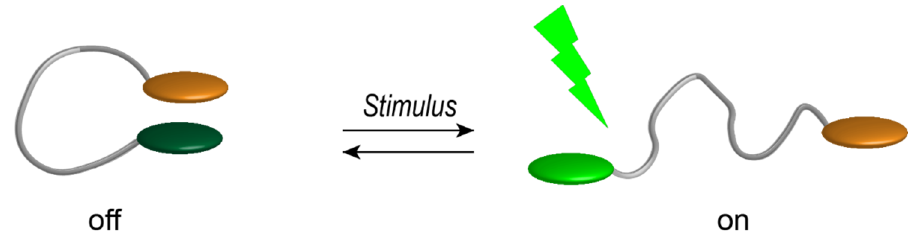
Figure 1. Schematic representation of a covalently connected dye pair that may form an intramolec- ular cyclic structure as a sensor element. In the idle state, the two dyes are in proximity and the fluorescence emission is quenched. Upon exposure to a suitable stimulus, the fluorophore and quencher are separated and the emission of the former is switched.